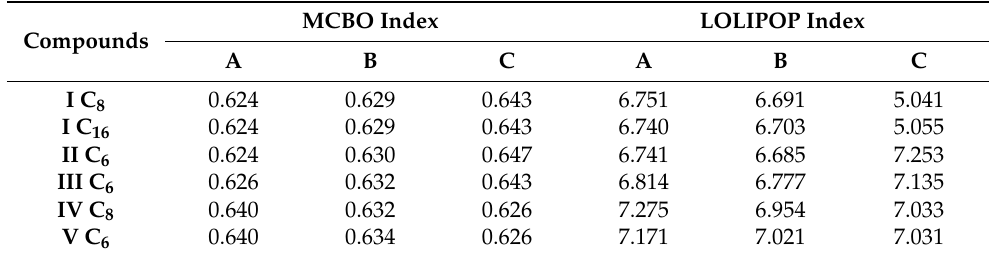
Table 6. The normalized multicenter bond order (MCBO) index and localized orbital locator inte- grated π over the plane (LOLIPOP) of compounds I C 8 , I C 16 , II C 6 , III C 6 , IV C 8 , and V C 6 . MCBO Index LOLIPOP Index Compounds A B C A B